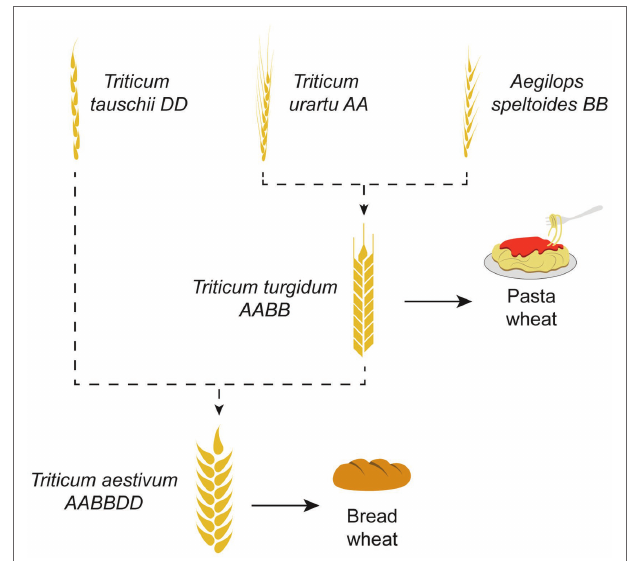
FIGURE 3 | The origin of bread wheat. Bread wheat ( Triticum aestivum ), is an allo-hexaploid originated via multiple hybridizations. The most accepted hypothesis of its origin is based on the hybridization of Triticum urartu (AA; 2× = 14) and Aegilops speltoides (BB; 2× = 14), resulting in tetraploid pasta wheat (AABB; 4× = 28). At the next step, hybridization of the tetraploid wheat with Aegilops tauschii (DD; 2× = 14) resulted in the emergence of the hexaploid bread wheat (AABBDD; 6× =